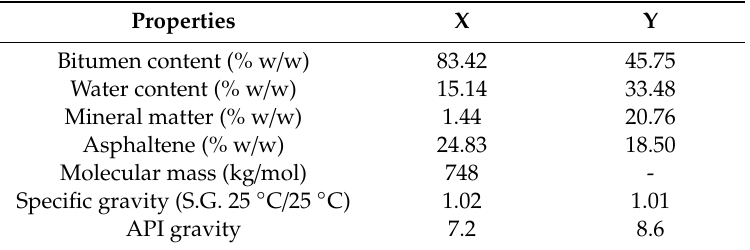
Table 1. Properties of Nigerian oil sands and bitumen. API, xxxxxxx.